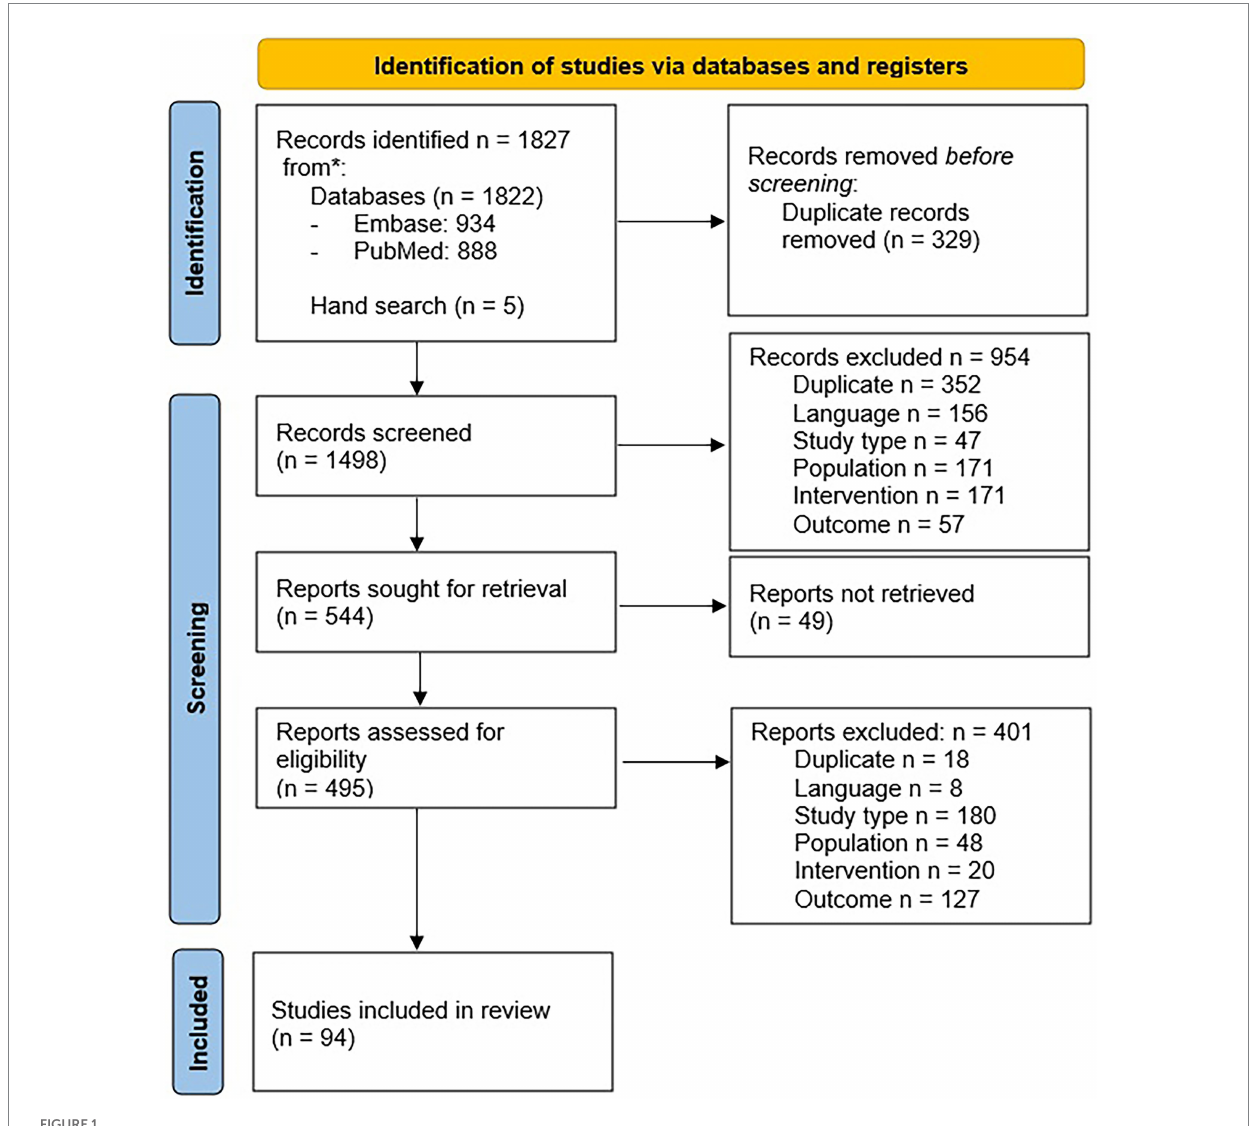
FIGURE 1 PRISMA 2020 flow diagram for systematic